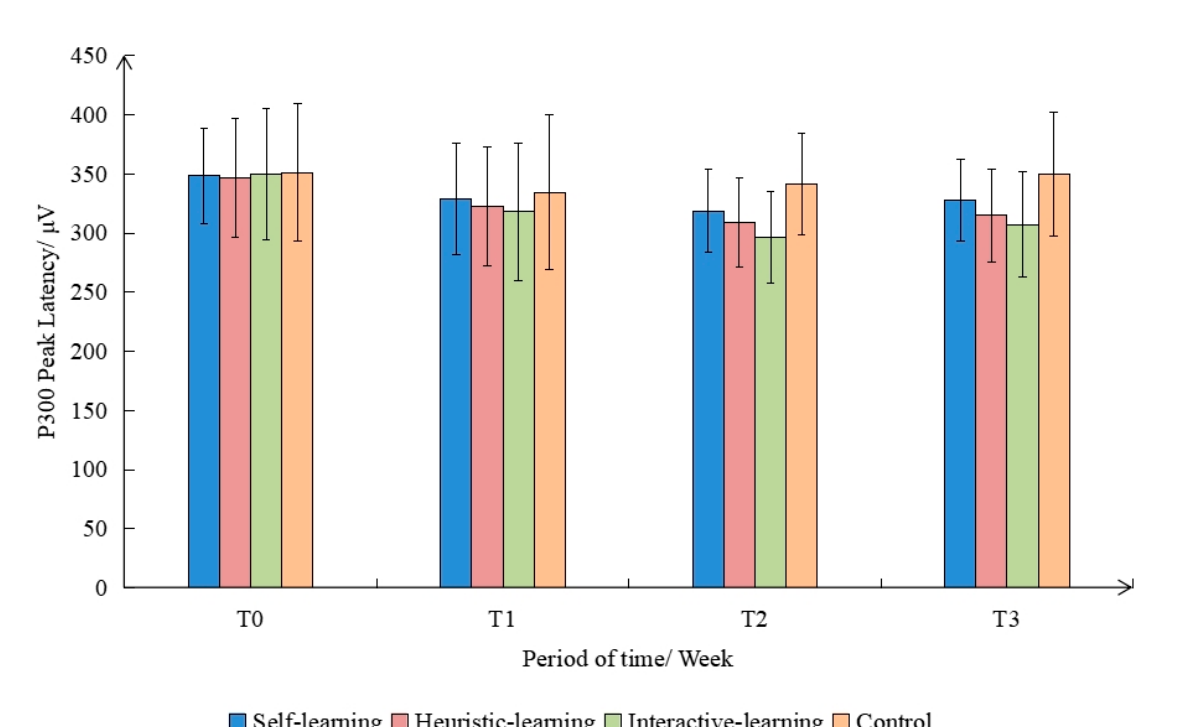
Figure 7. Comparison of P300 peak latency in different groups and time periods.